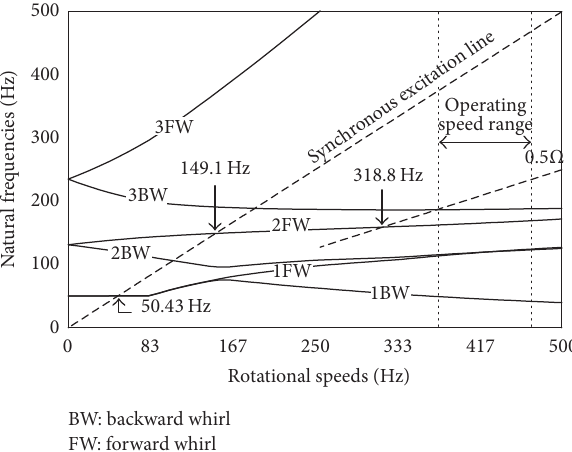
Figure 6: Campbell diagram for the radial clearance of the squeeze film damper equal to 0.12